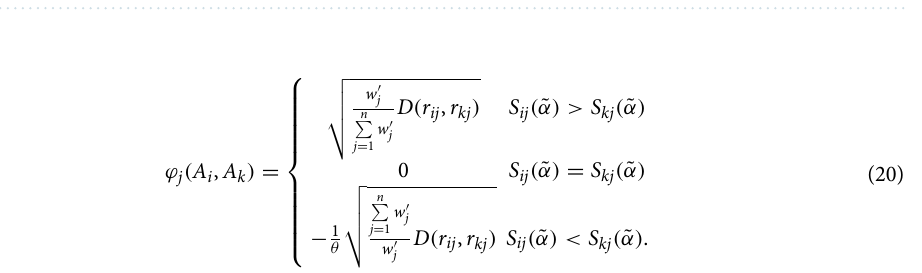
Table 4. Interval-valued intuitionistic fuzzy matrix given by decision-maker E 4 .